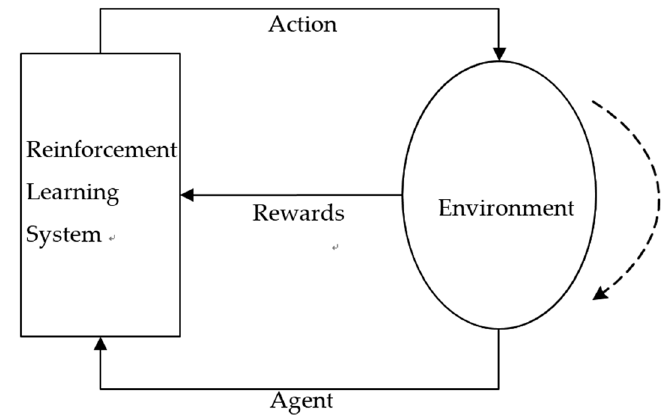
Figure 1. Reinforcement learning process.